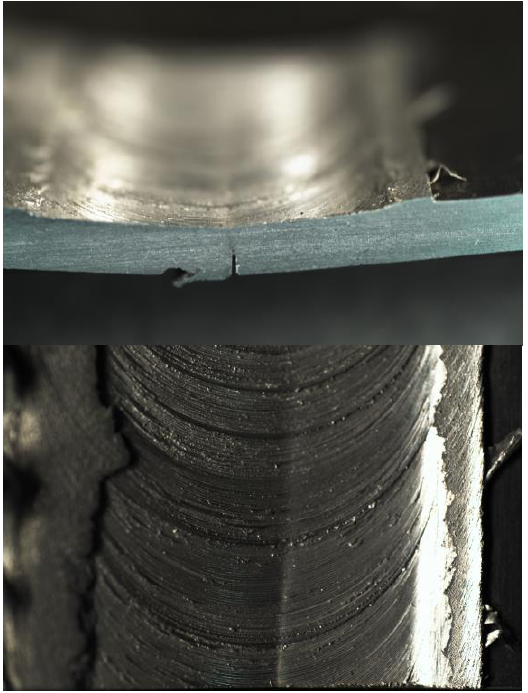
Figure 15. Fracture in the HAZ on the aluminum side for welding 9 specimen C.